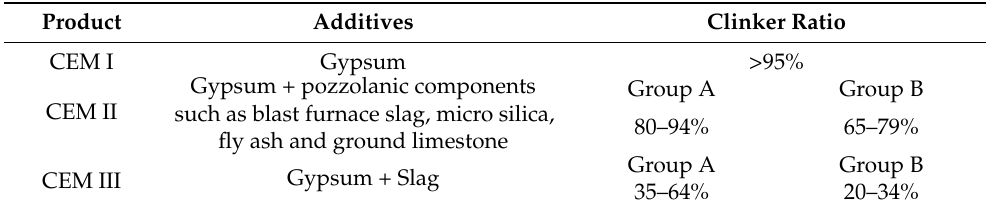
Table 1. The percentage of different types of cement used in production, as well as their components. Product Additives Clinker Ratio CEM I Gypsum >95% Gypsum + pozzolanic components Group CEM II such as blast furnace slag, micro silica, fly ash and ground limestone